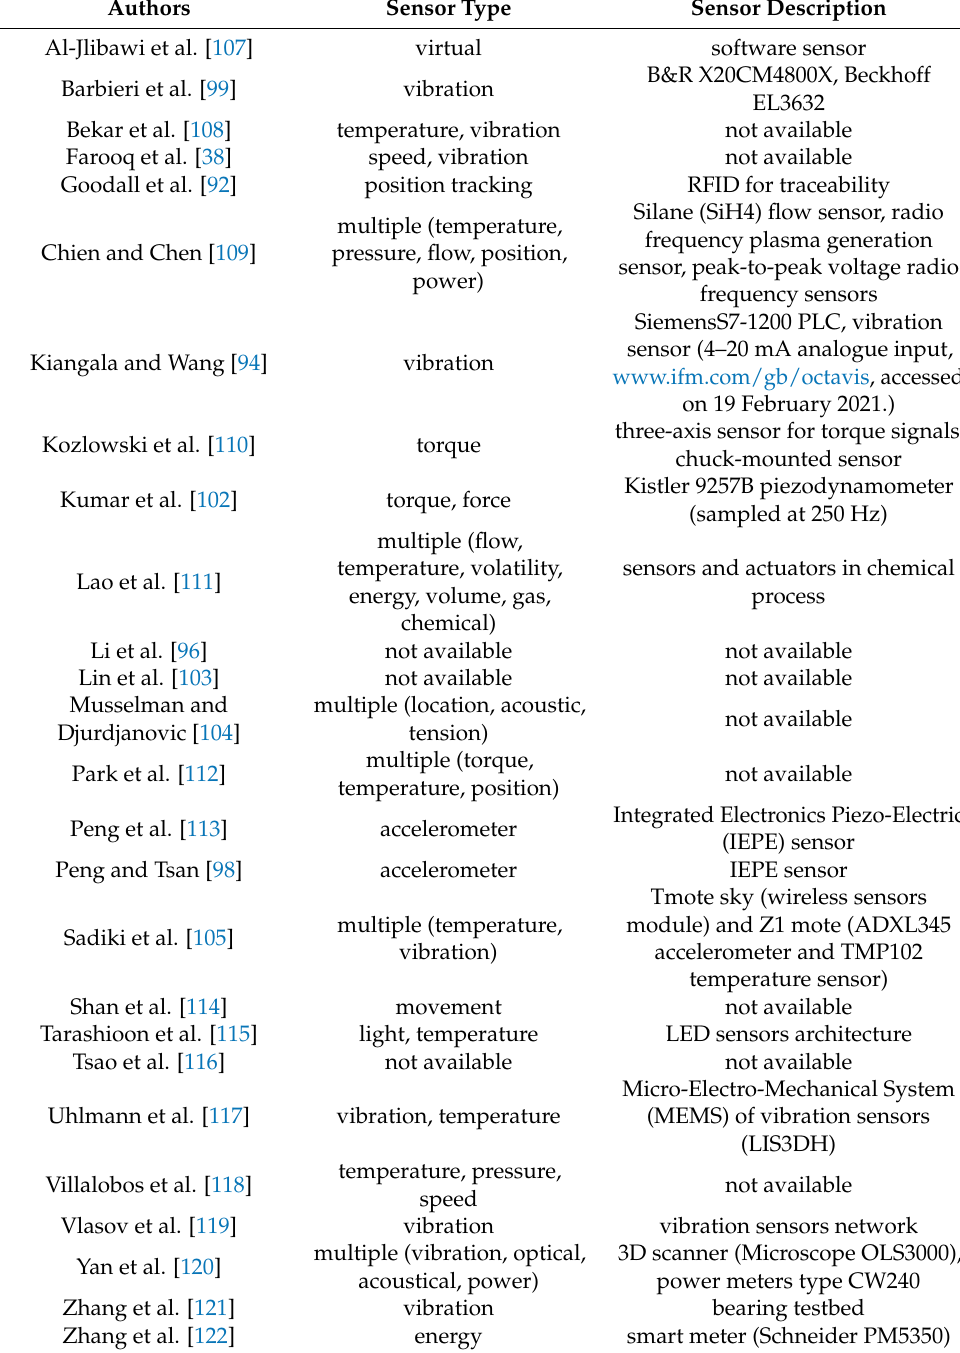
Table 9. Sensors’